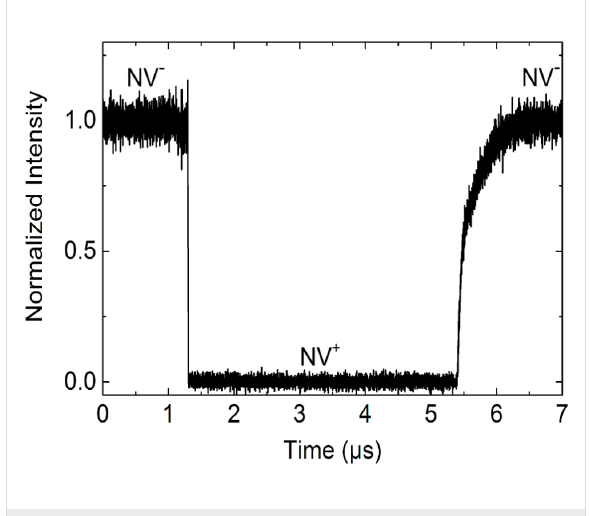
Figure 5: Fast charge state switching. The result of the time-resolved NV-intensity measurement shows that switching from NV − to NV + takes place much faster than switching from NV + to NV − . Since in this case we used an NV − filter in front of an ADP, the maximum and the minimum of the detected intensity corresponds to the NV − and NV + state